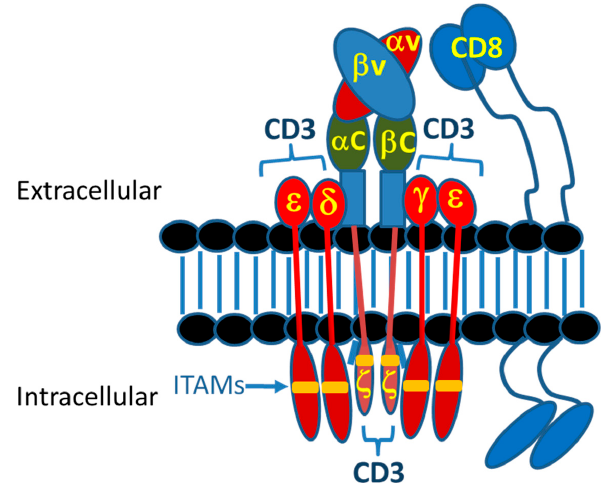
Figure 5. Diagram of the T-cell receptor (TCR) complex. Normal TCR-pMHC interactions are in